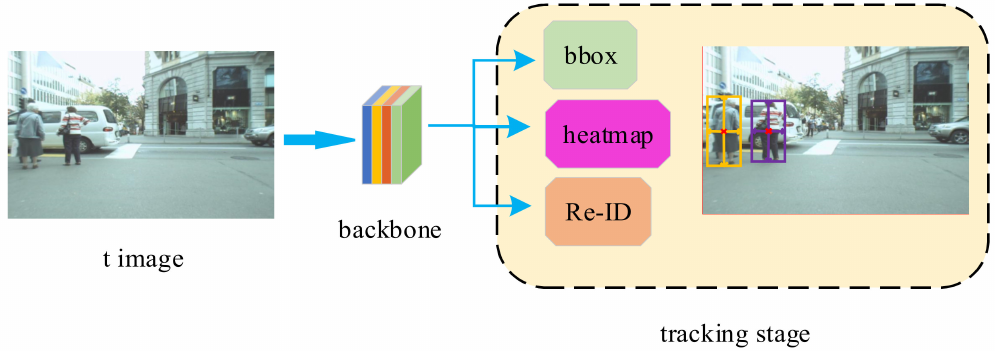
Figure 2. Simplified FairMOT